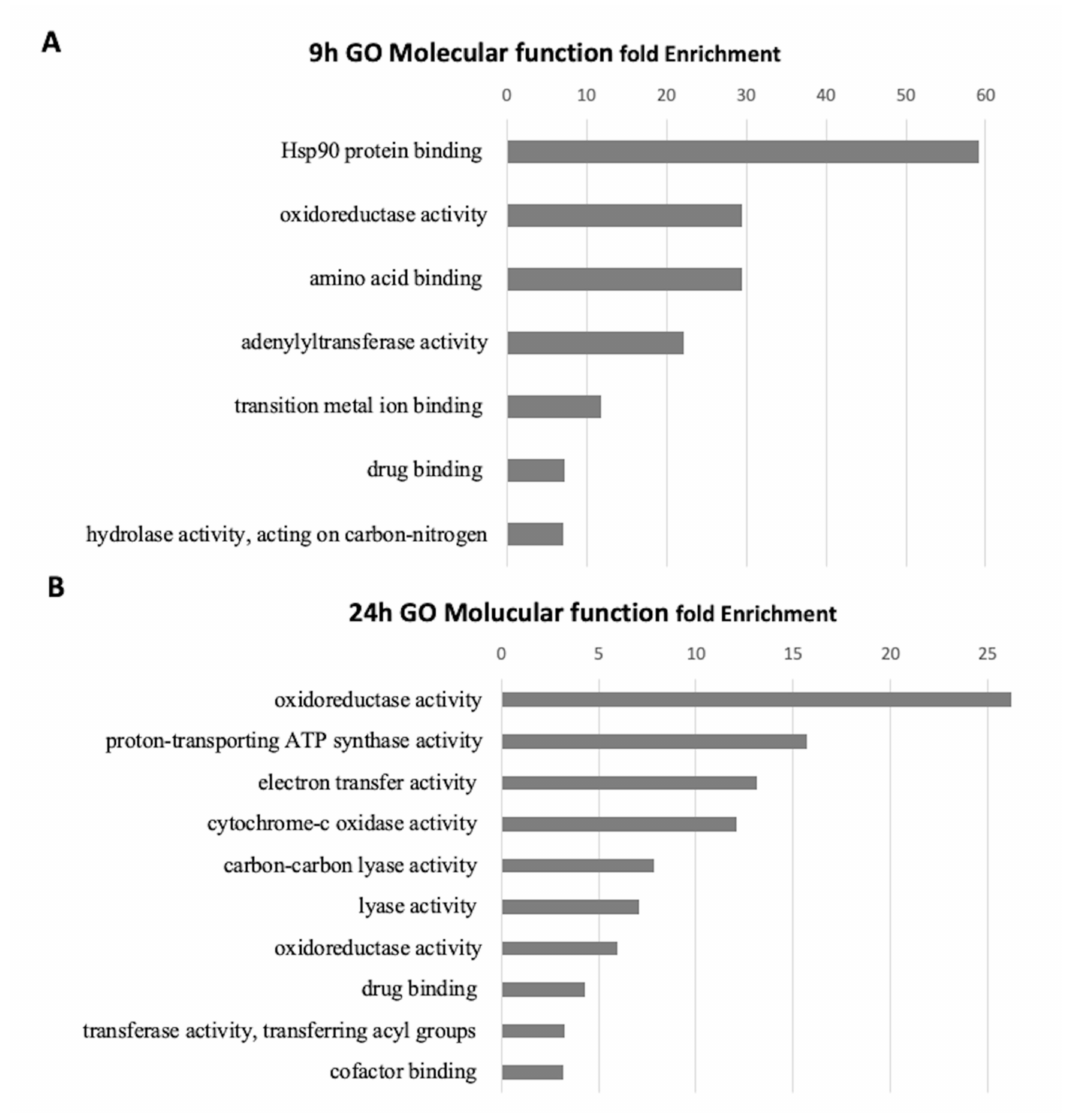
Figure 4. Gene ontology and enrichment analyses with fold enrichment = − log10 (Fisher’s exact p -value) for molecular function: ( A ) 9 h; ( B ) 24 h. Proteins obtained with